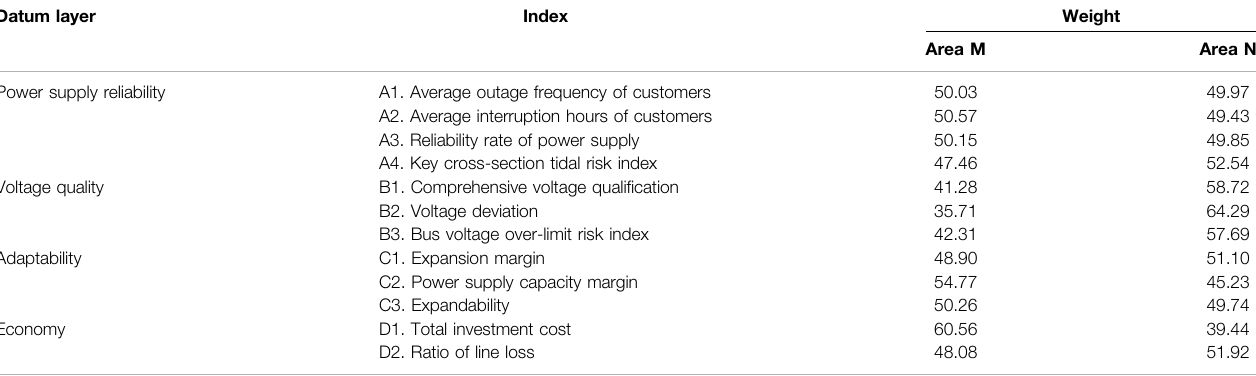
TABLE 3 | Relative scores of all indicators.